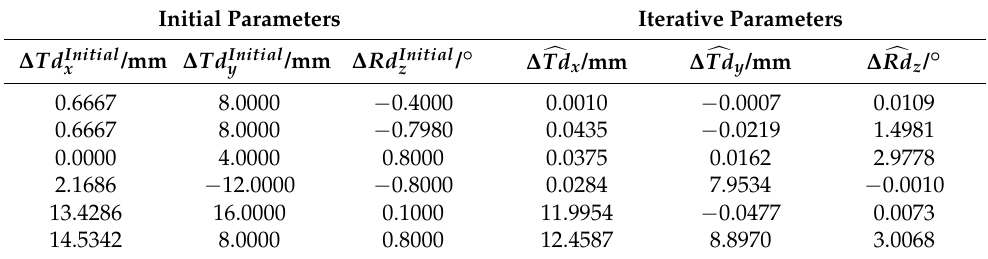
Table 2. Calculated parameters.